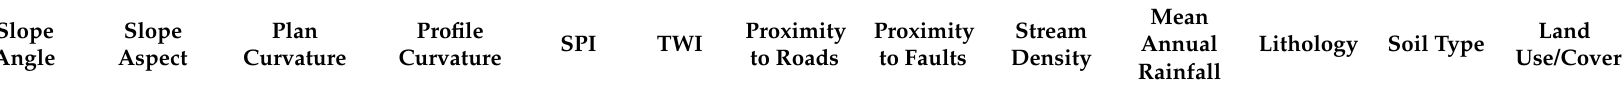
Table 5. The q-statistic values for the pairwise interactions between the conditioning factors, calculated using